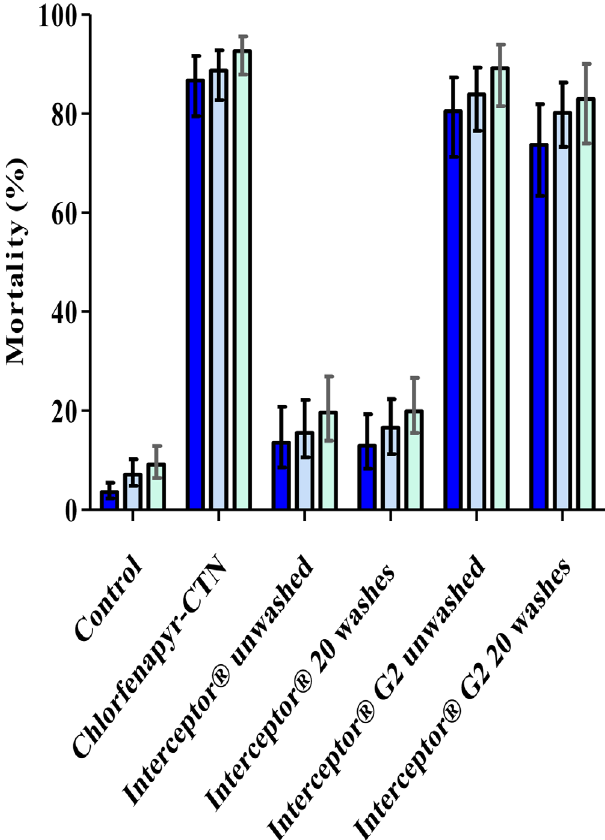
Figure 3. Mortality of An. gambiae s.l. during overnight, 24 h, and 72 h after exposure to different nets in the experimental huts. Deep blue: immediate mortality; intermediate blue: mortality after 24 h; light blue: mortality after 72 h.